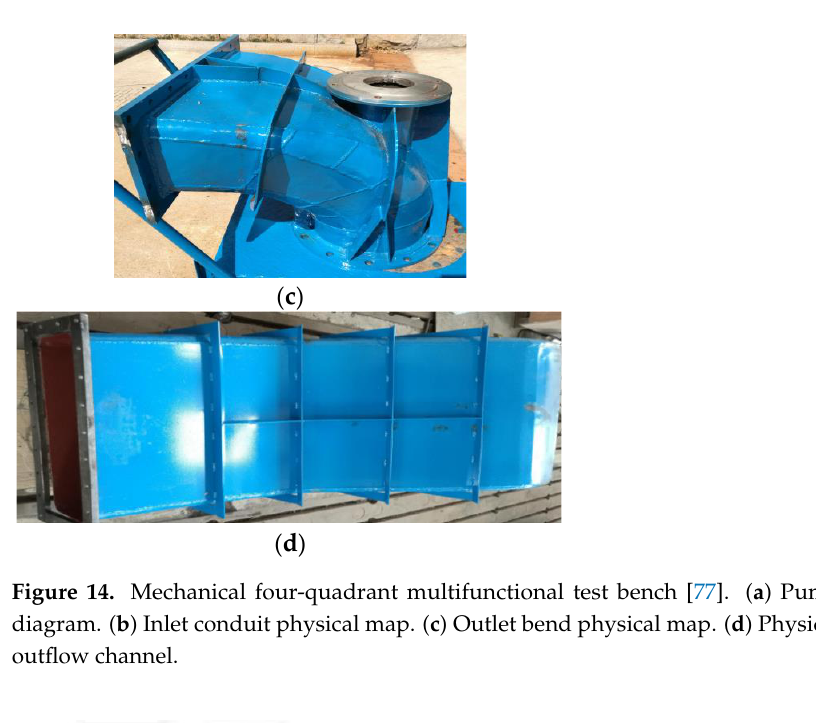
Figure 14. Mechanical four-quadrant multifunctional test bench [77]. ( a ) Pump model system diagram. ( b ) Inlet conduit physical map. ( c ) Outlet bend physical map. ( d ) Physical drawing of the outflow channel.